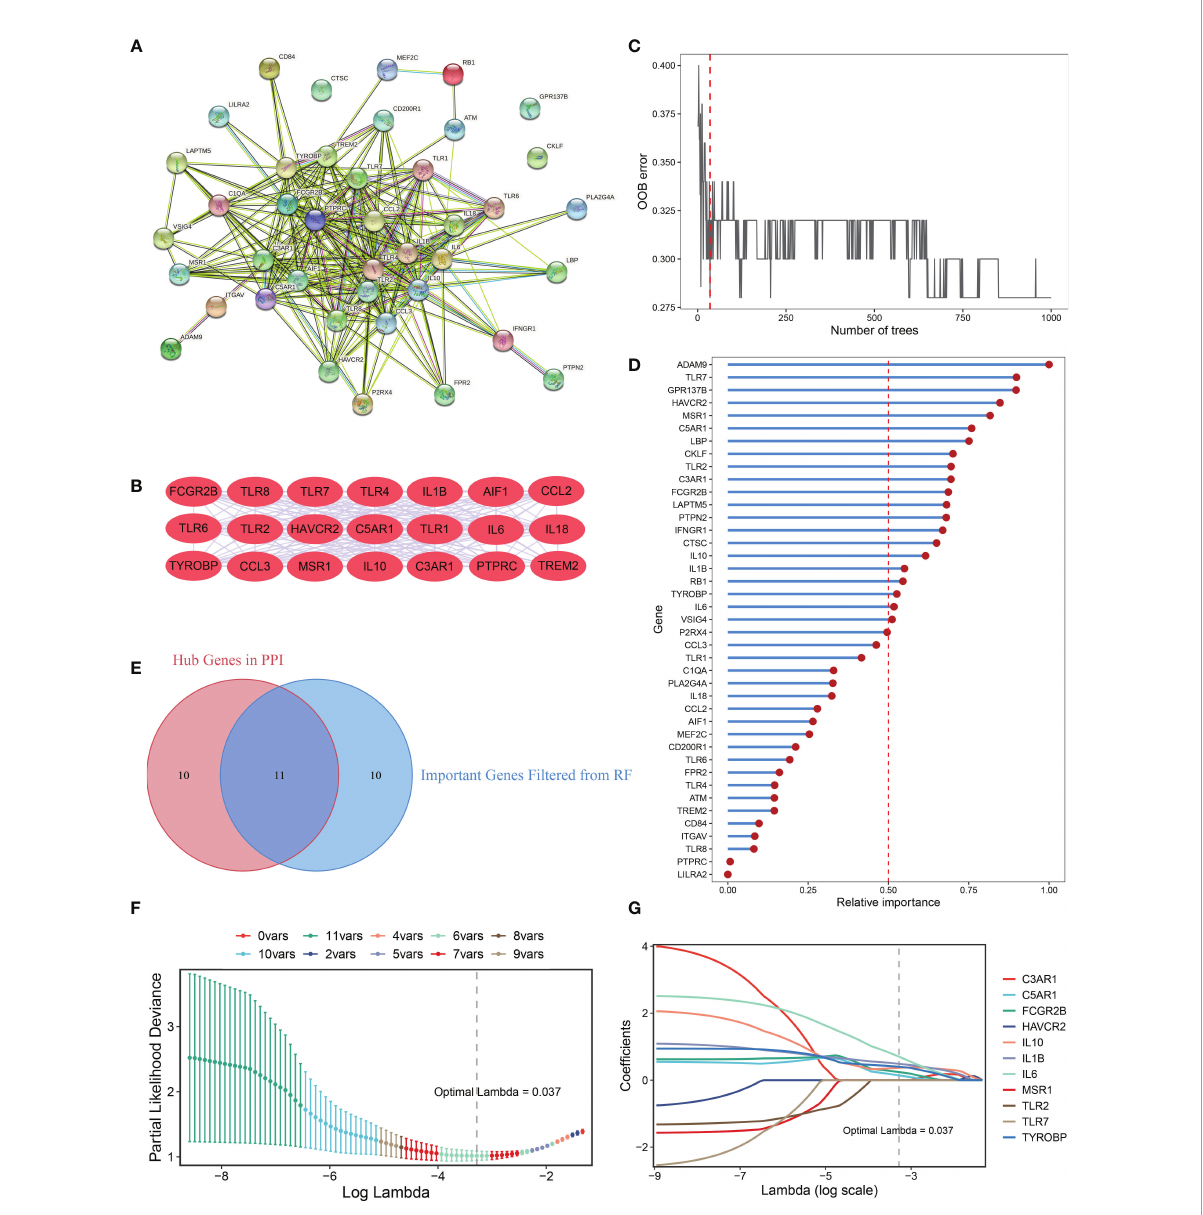
FIGURE 4 Integrative construction of the MAGDS. (A) Protein-Protein Interaction (PPI) network of DEMAGs. (B) The 21 red nodes we highlighted in the network were hub genes identi fi ed by cytoHubba-degree algorithm. (C) Out of bag (OOB) error rate reached a minimum when the number of trees was equal to 35. (D) Relative importance of 41 up-regulated DEMAGs calculated in random forest. (E) Venn diagram of the intersection of important gene variables obtained from PPI analysis and random forest pre-screening. (F) The optimal lambda was determined when the partial likelihood deviance reached the minimum value. (G) LASSO coef fi cient pro fi les of the candidate genes for MAGDS